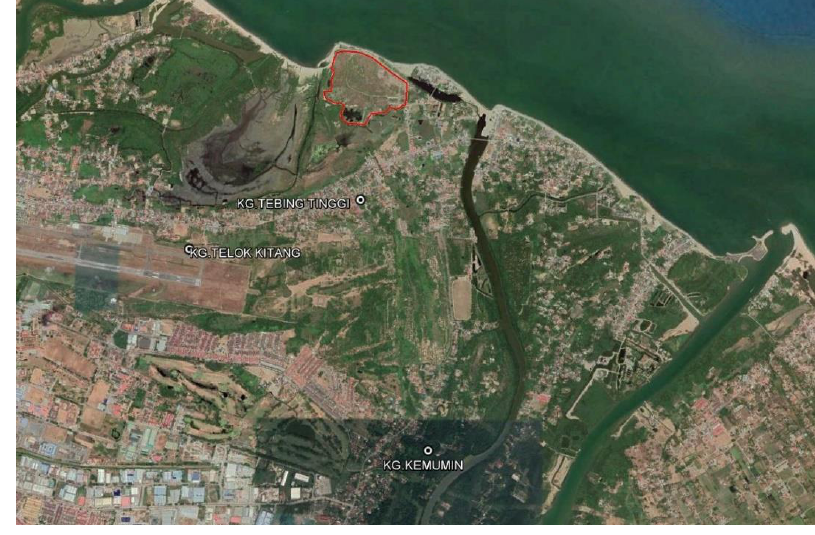
Figure 1. Satellite map of Sabak dumpsite, Kelantan, Malaysia. Int. J. Environ. Res. Public Health 2020 , 17 , x